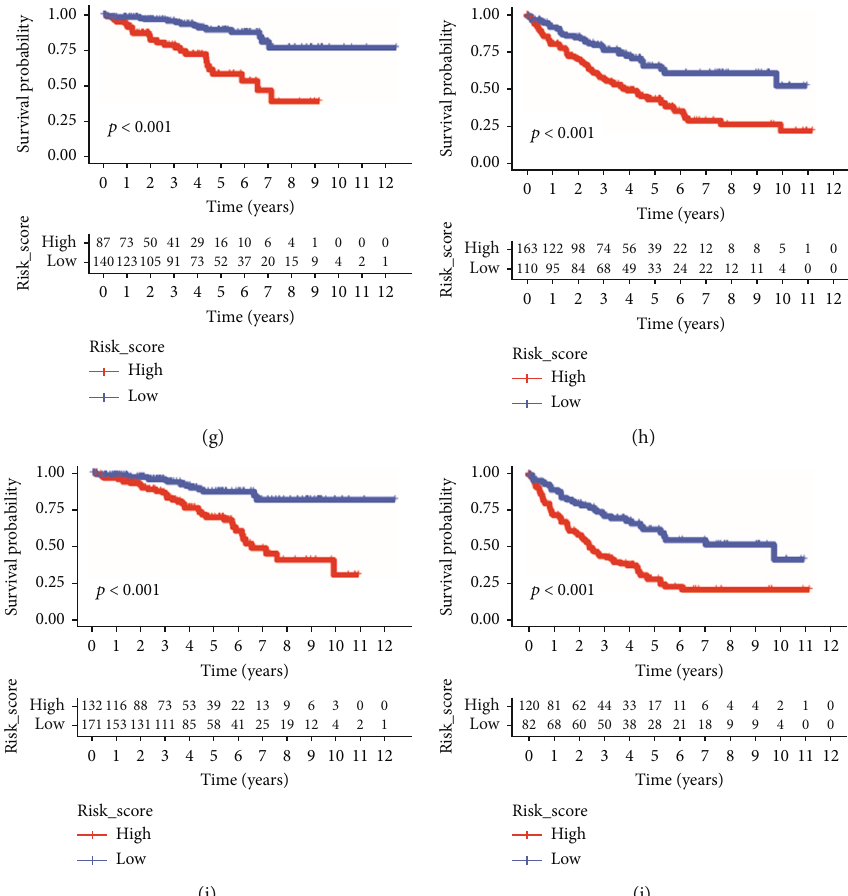
Figure 4: Independent prognostic signi fi cance and clinical subgroup analysis of clear cell renal cell carcinoma (ccRCC) signature. (a) Forest plot of the results of the univariate Cox regression analysis of overall survival for risk score and clinical characteristics in the training cohort. (b) Forest plot of the results of the multivariate Cox regression analysis of overall survival for risk score and clinical characteristics in the training cohort. (c) Risk score levels in the dead and alive groups. (d) Percentage of patients ’ status in the low- and high-risk groups. Kaplan – Meier plot of patients with di ff erent clinical features: (e) age ≤ 60 ; (f) age > 60 ; (g) histological grades 1-2; (h) histological grades 3-4; (i) pathological stages I-II; (j) pathological stages